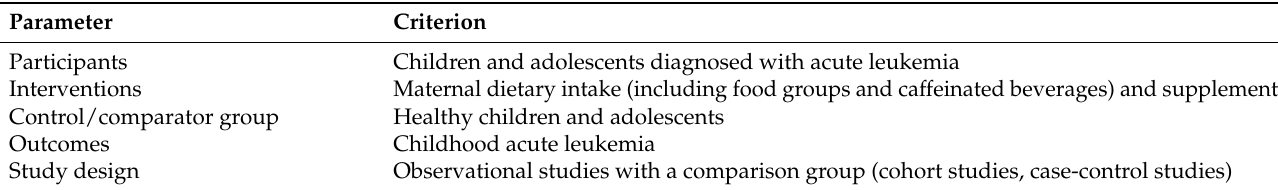
Table 2. PICOS criteria for inclusion and exclusion of studies.